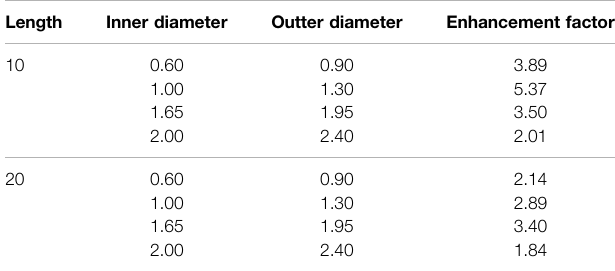
TABLE 1 | Enhancement effect of Raman signals with different sizes of quartz tubes